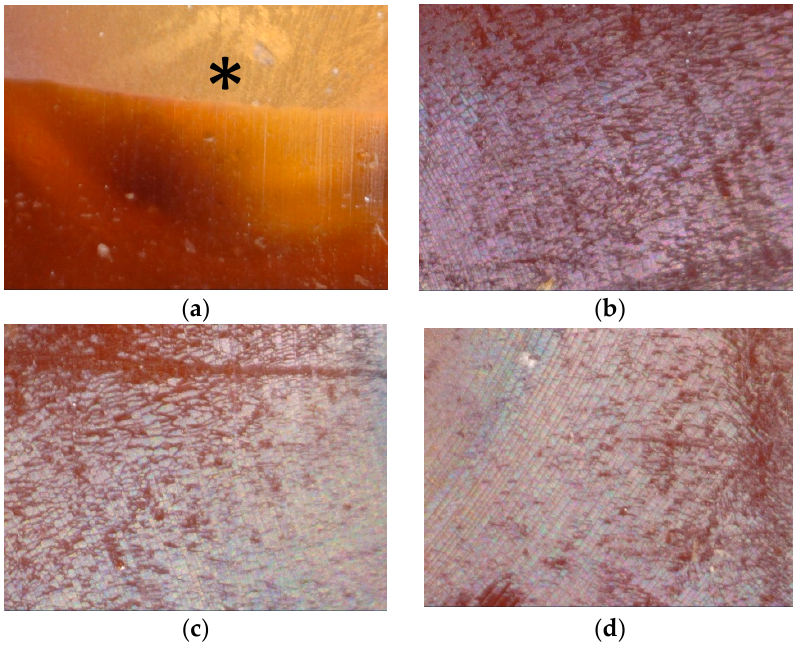
Figure A2. Optical microphotograph (2 × 1.5 mm) of EPDM rubber after 5 × 10 14 ions/cm 2 PIII. ( a ) the edge of the mask (* marks the treated area). ( b – d ) are in a center of the treated area.